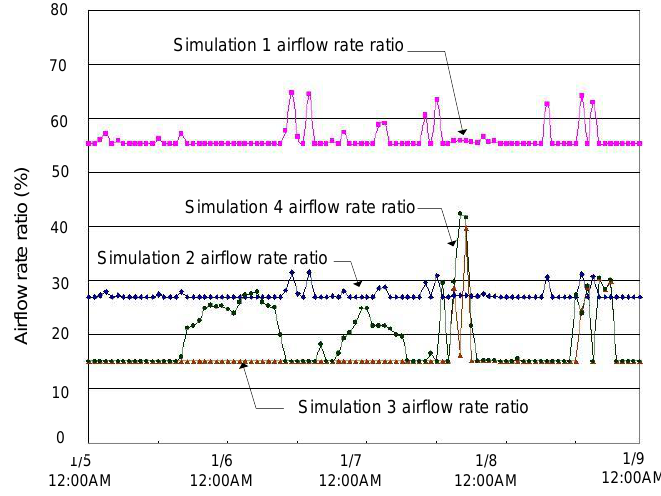
Figure 4. Simulation results of north zone airflow rate ratio.